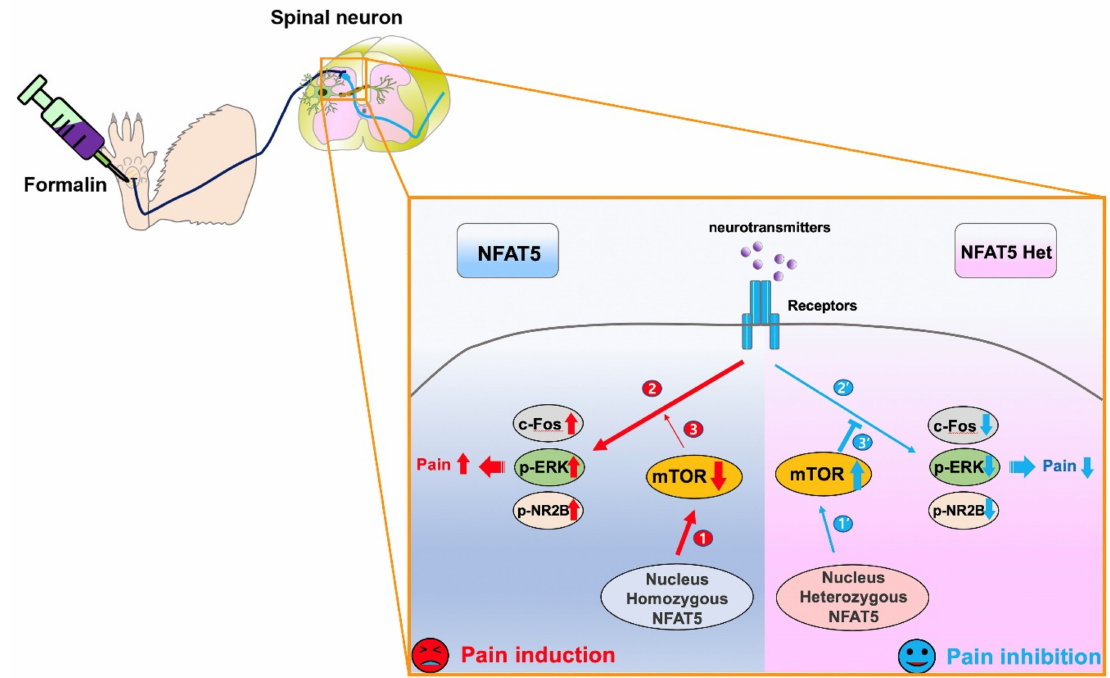
Figure 8. The loss of formalin-induced inflammatory pain in NFAT5-depleted mice. In normal mice, NFAT5 basically inhibits the gene expression of mTOR ( 1 ). When formalin was administrated to generate inflammatory pain, substances released from nerve terminals of primary afferent neurons bound to their receptors on post-synaptic neurons and induced pain by the phosphorylation of pain-related factors such as c-Fos, p-ERK, and p-NR2B in spinal neurons (2), with no interference of lower mTOR levels (3). On the other hand, in NFAT5-depleted mice, elevated levels of mTOR protein (1’) inhibited pain induction through the suppression of pain-related factors (2’,